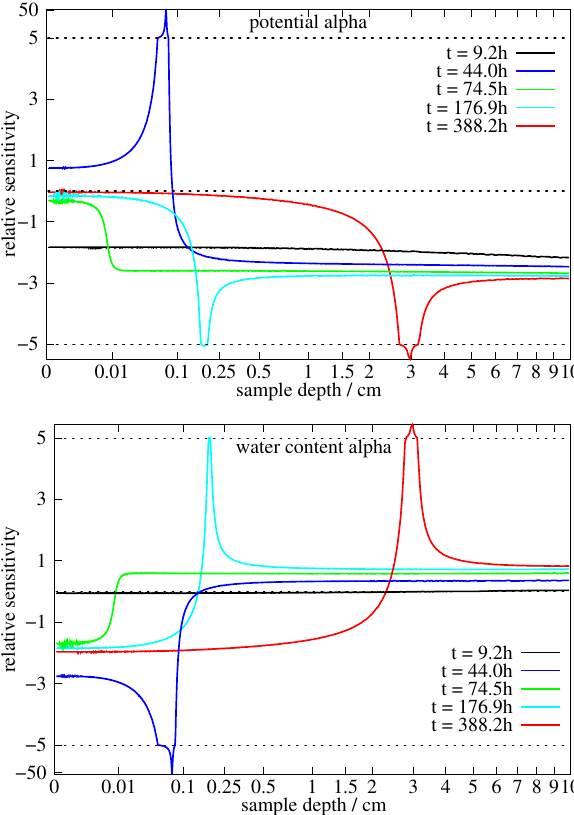
Fig. 10. Relative sensitivity s(z,t i ) on α of the potential ψ m (top) and the water content θ (bottom), respectively, versus height z for different times t i , both for the threestep experiment. Note the switch in the sensitivity scale, marked with a dashed black line, and the non-linear scaling of the depth axis.